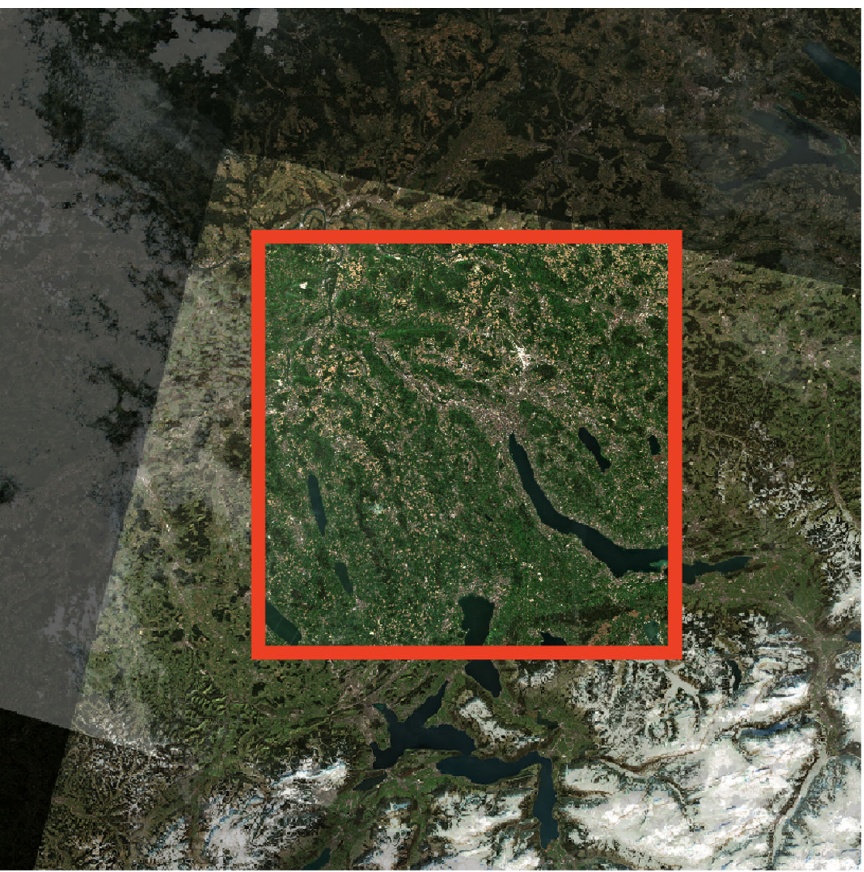
Figure 2. An overlay of several TCI S2A_MSIL2A images with 50% opacity, with darker shaded areas highlighting the no_data coverage stripes affecting images from the time series; the selected area is marked with the red rectangle, centered on the location of interest in Birmensdorf, CH.